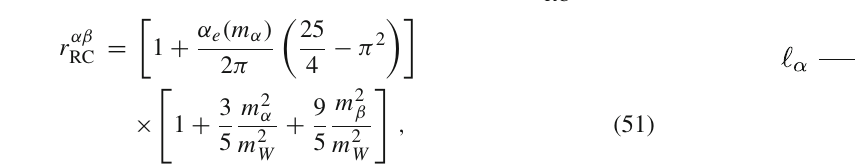
in which (cid:14) i = m i / m (cid:4) , m i being the mass of the